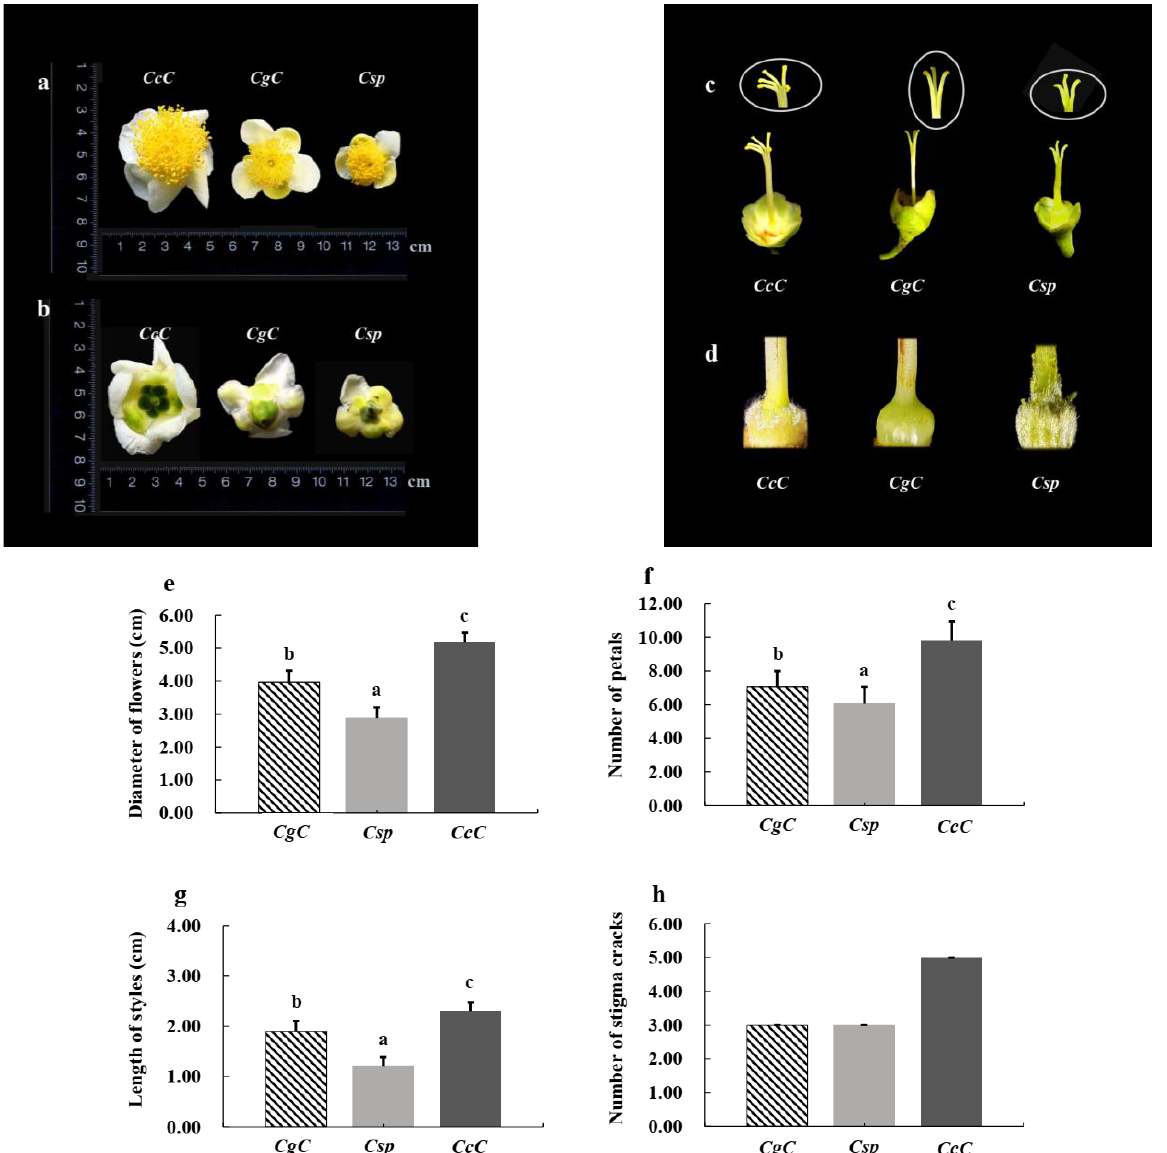
Figure 2. Flower Morphology of three Camellia species. ( a ) Front of flowers of three Camellias Species; ( b ) back of flowers of three Camellia species; ( c ) styles and stigmas of three Camellia species; ( d ) ovaries of three Camellia Species; ( e ) diameter of flowers of three Camellia species; ( f ) number of petals of three Camellia species; ( g ) length of styles of three Camellia species; ( h ) number of stigma cracks of three Camellia species; CgC , C. gymnogyna Chang ; Csp , C. sinensis var. pubilimba Chang ; CcC , C. crassicolumna Chang . Values are mean ± SD ( n = 20). Different lowercase letters mean significant differences at p < 0.05 (Tukey’s HSD). Table 1. Main floral morphology of three Camellia species.